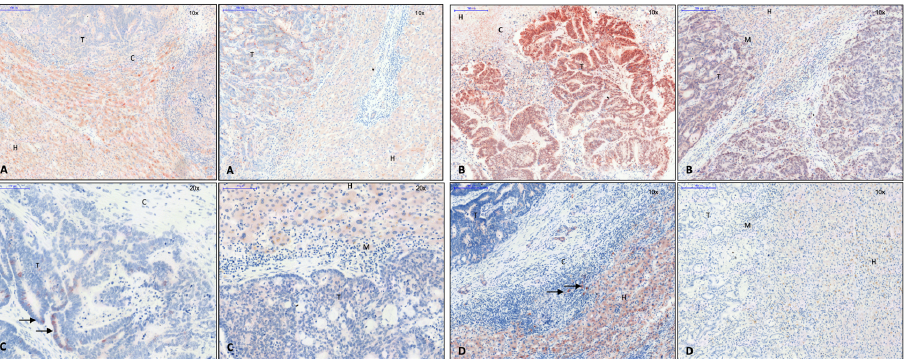
Figure 3. Left: capsule; right: no capsule. ( A ) Snail 1 immunohistochemistry, 10× magnification. Expression of Snail 1 in cytoplasm of cells near the tumor margin, mostly in encapsulated CRLM, and in cytoplasm of tumor cells, mostly in CRLM without capsule. ( B ) Snail 3 immunohistochemistry, 10× magnification. Expression of Snail 3 in nuclei of tumor cells at the margin of encapsulated CRLM. ( C ) Sox 10 immunohistochemistry, 20× magnification. Expression of SOX 10 at the membrane and in cytoplasm of tumor cells of encapsulated CRLM (arrows). ( D ) Twist immunohistochemistry, 10× magnification. Expression of Twist 1 in cytoplasm of cells close to the tumor margin in encapsulated CRLM (arrows). Legend: T, tumor; H, hepatocytes; M, tumor margin; C, capsule.